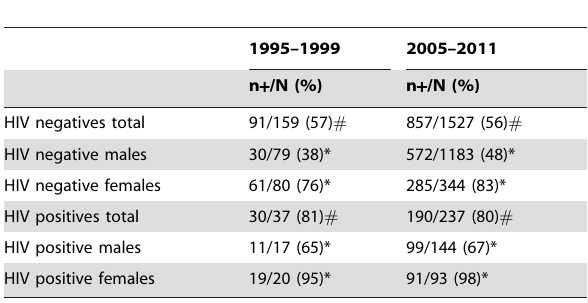
Table 3. HSV-2 seroprevalence by HIV seroprevalence and by gender among never-injecting drug users, New York City,